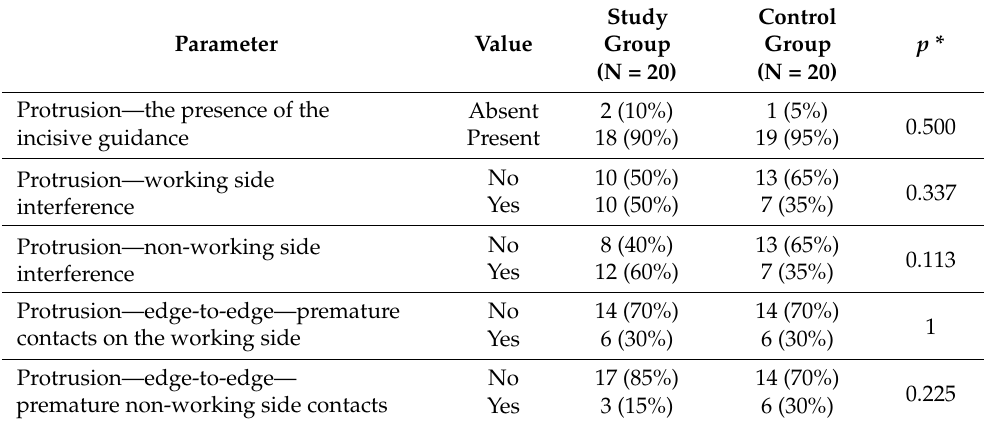
Figure 3. Aspects of the T-Scan recording of the protrusion movement for a participant with bruxism. Table 5. Evaluation of protrusion movement according to the presence of incisal guidance, working and non-working interferences, and premature contacts.